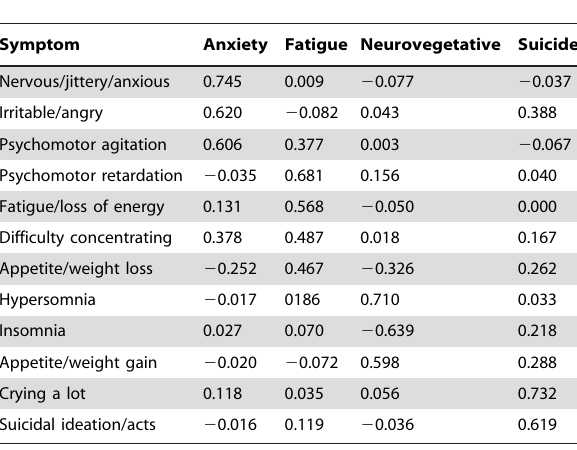
Table 4. Factor loadings obtained from analysis of 12 major depression symptoms from structured